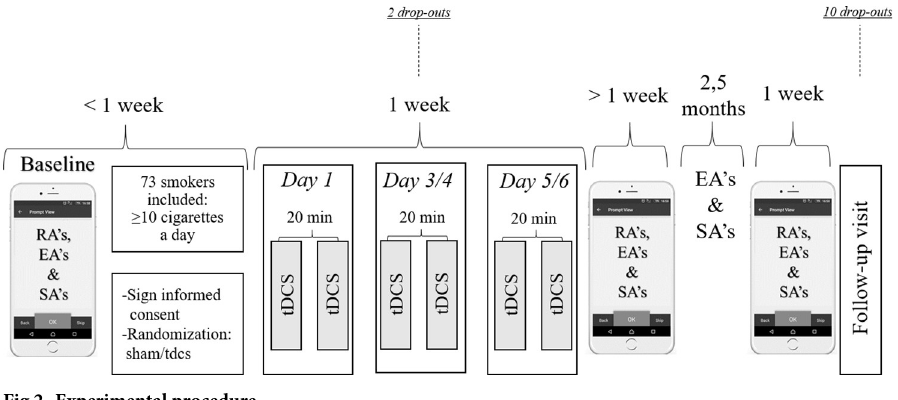
Fig 2. Experimental